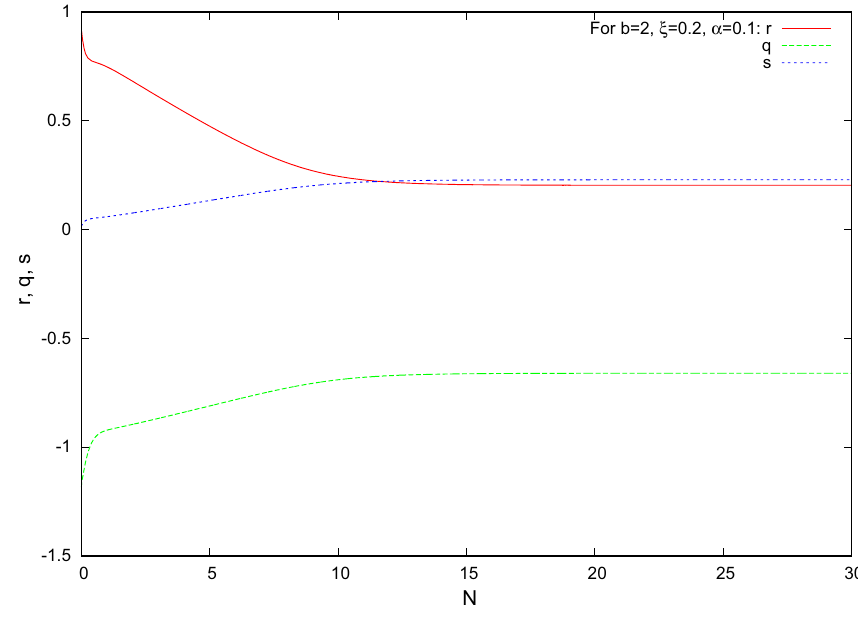
For b=2, ξ =0.2, α =0.1: r